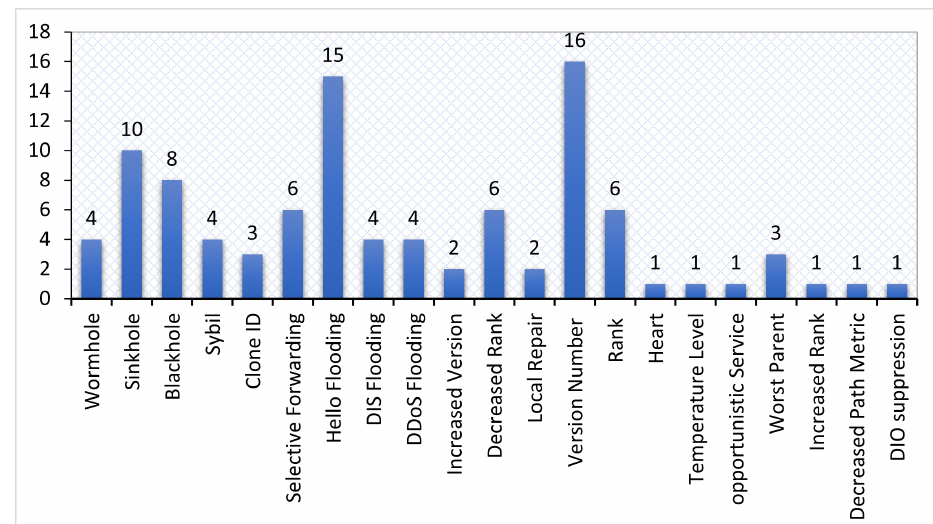
Figure 8. Distribution of the attacks in the existing studies.